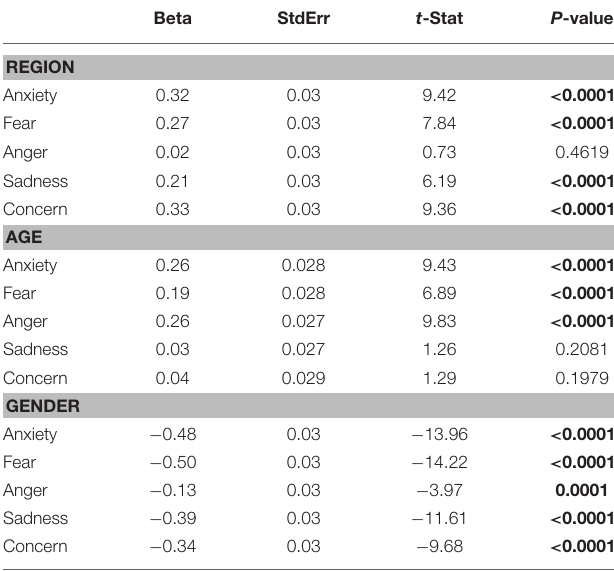
TABLE 2 | Multinomial logistic regression data for psychological impact category and demographic factors (region, age, and gender). Beta StdErr t -Stat P -value